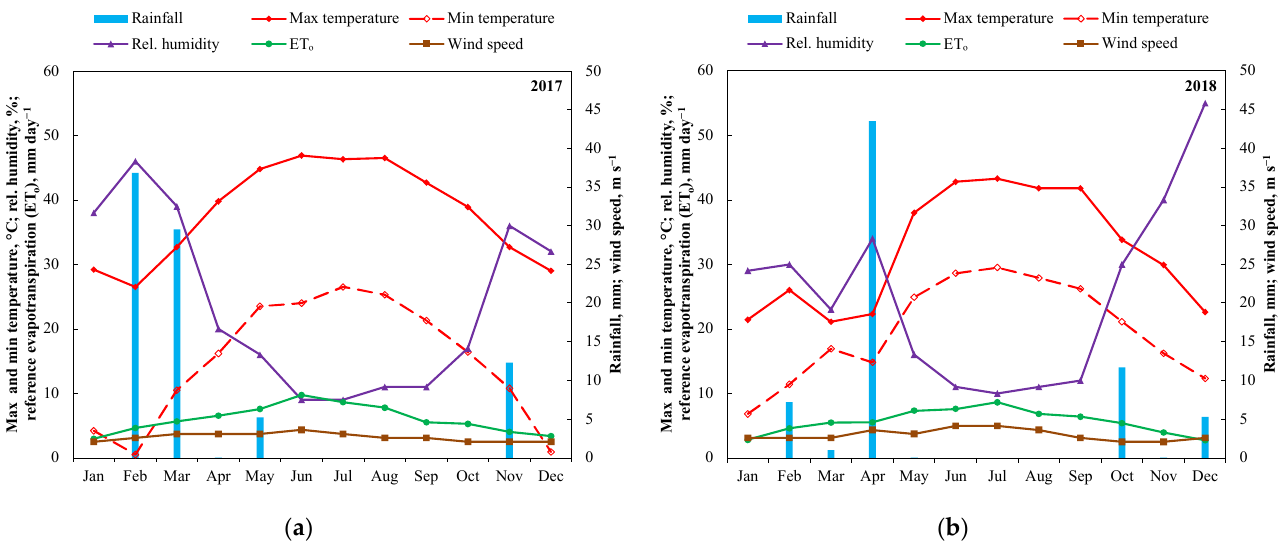
Figure 1. Average monthly values of climate parameters present in the experimental site during the study period: ( a ) 2017; ( b ) 2018.